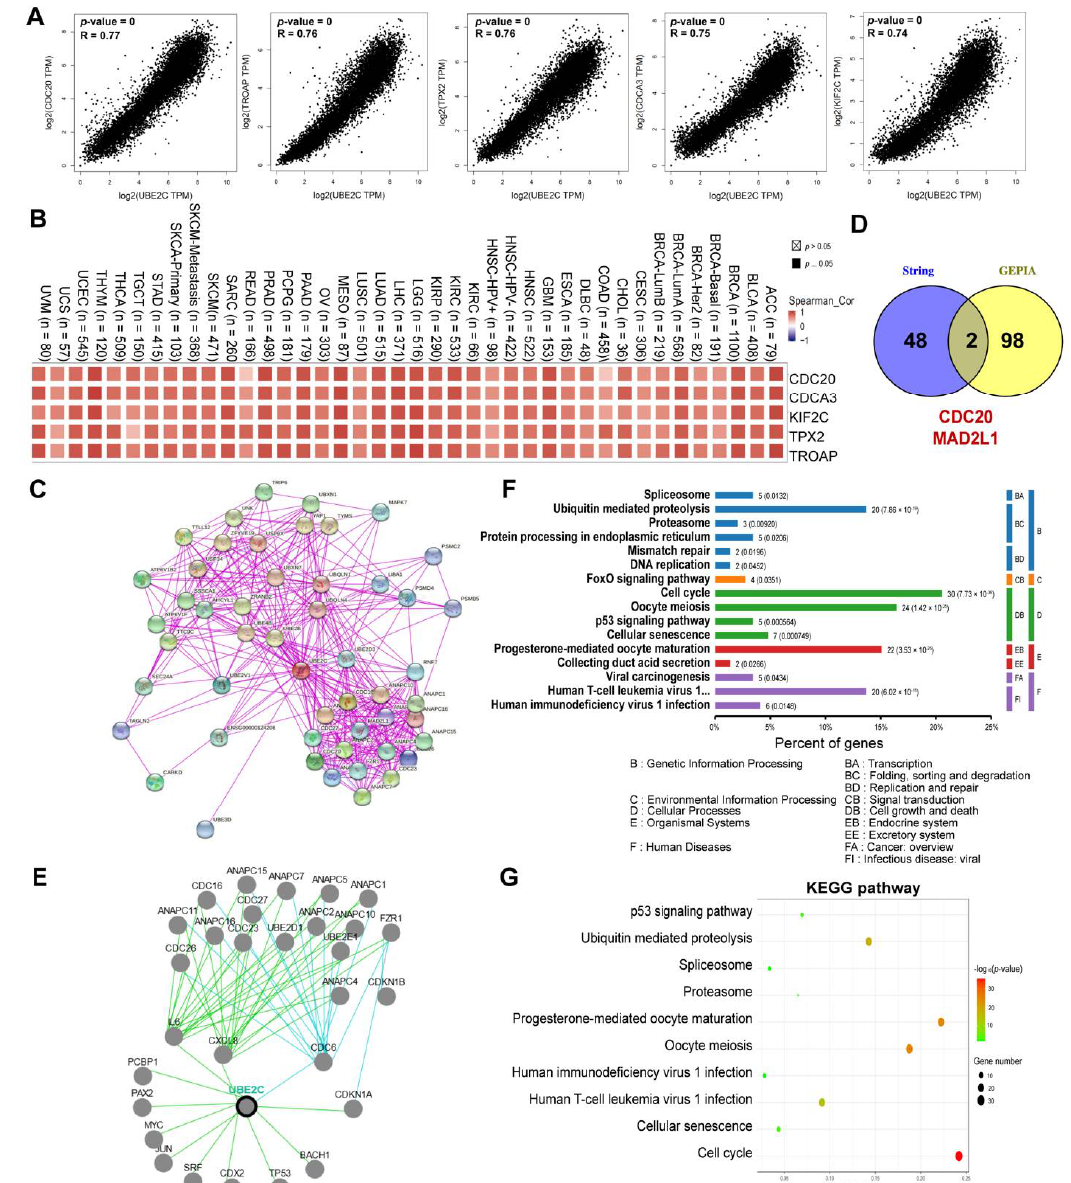
Figure 5. Coexpressed genes, targeted miRNA, and lncRNA of UBE2C ( A ). The correlation of UBE2C expression levels and CDC20, TROAP, TPX2, CDCA3, and KIF2C expression levels from the GEPIA2.0 website. p < 0.01. ( B ). Spearman correlation heatmap of the above five genes (CDC20, TROAP, TPX2, CDCA3, and KIF2C) and UBE2C for a variety of cancers. The results were obtained by TIMER2.0. ( C ). A total of 50 proteins that interact with UBE2C were obtained using STRING. ( D ). The intersection of the 50 proteins that interact with UBE2C and the 100 coexpressed genes identi- fied two genes: CDC20 and MAD2L1. ( E ). The genes that controlled the expression (indicated by